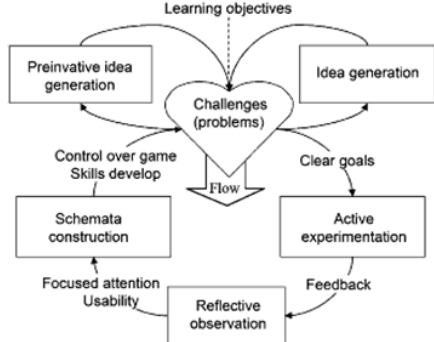
Figure 1. Experimental gaming